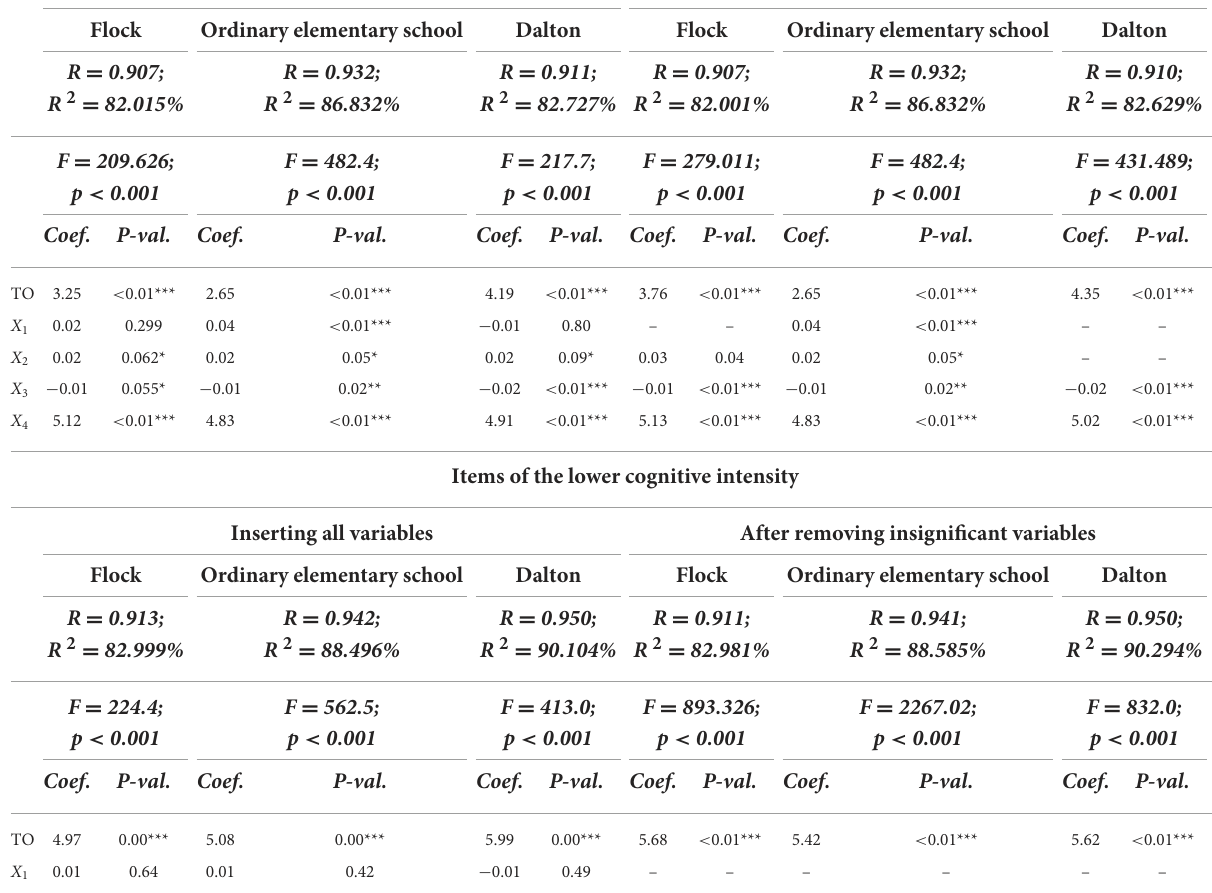
TABLE 3 Regression analysis according to the preferred learning management strategies at different types of schools (all variables). Items of the higher cognitive intensity Inserting all variables After removing insignificant variables Flock Ordinary elementary school Dalton Flock Ordinary elementary school Dalton